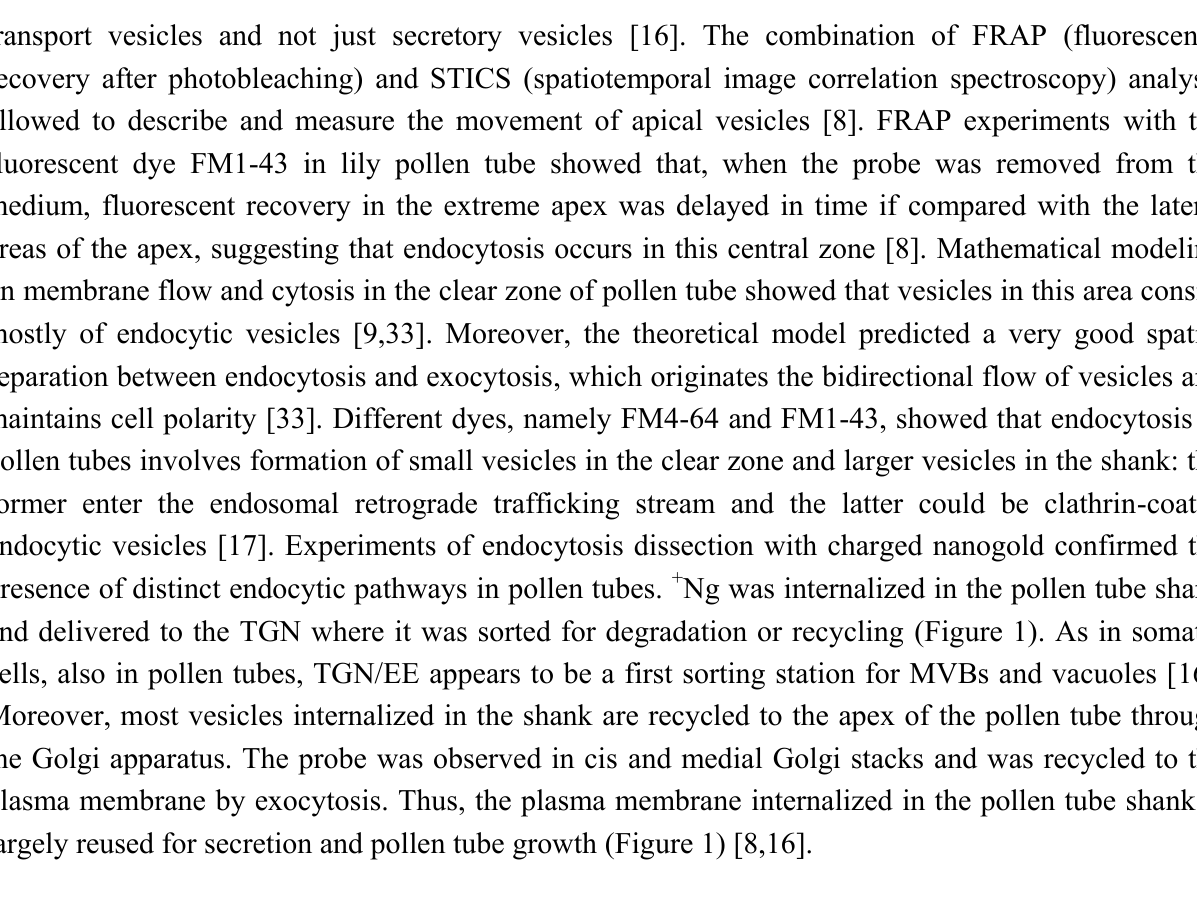
Figure 1. Model of exocytic/endocytic pathways contributing to pollen tube